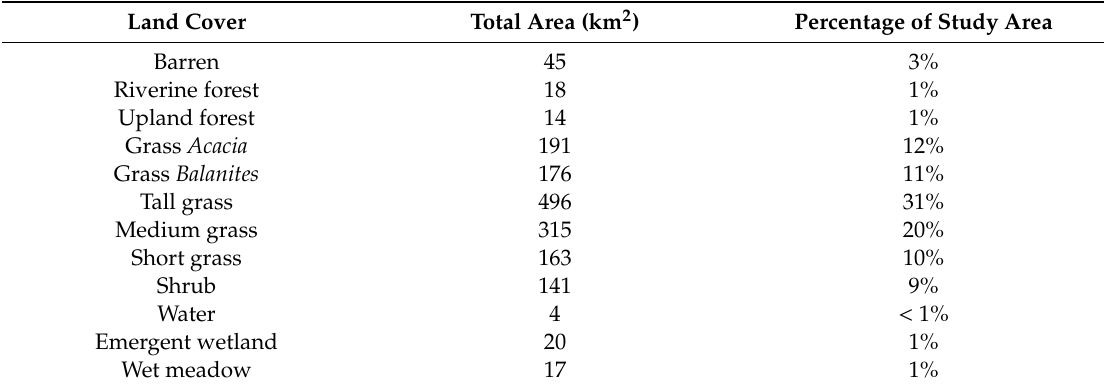
Table 4. Total area and percentage of Masai Mara National Reserve covered by each land cover class, based on the output of Random